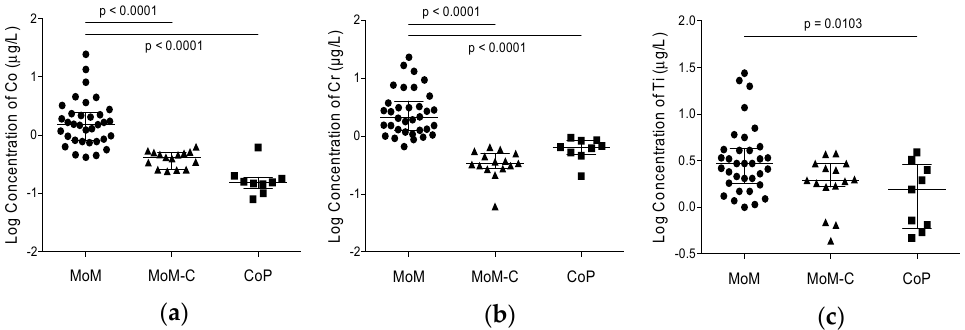
Figure 1. Vertical scatter plots showing whole blood metal ion concentrations after logarithmic transformation of the data for comparison between the three groups of: ( a ) cobalt; ( b ) chromium; and ( c ) titanium. Lines with p values connect groups with significant differences. Horizontal bars show medians with interquartile ranges. MoM, Metal-on-Metal study group; MoM-C, Metal-on-Metal control group; CoP, Ceramic-on-polyethylene control group.